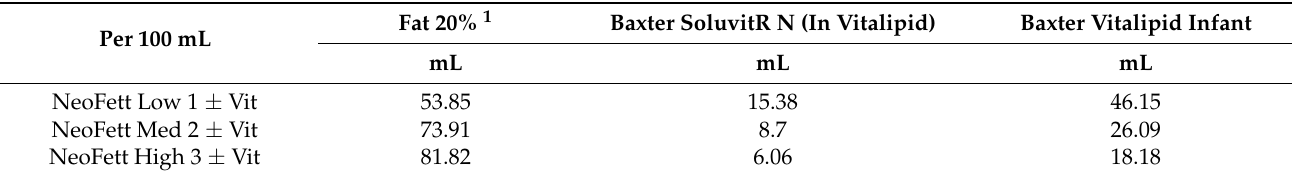
Table 5. ‘NeoFett’ solutions, containing fat and vitamins, supply per 100